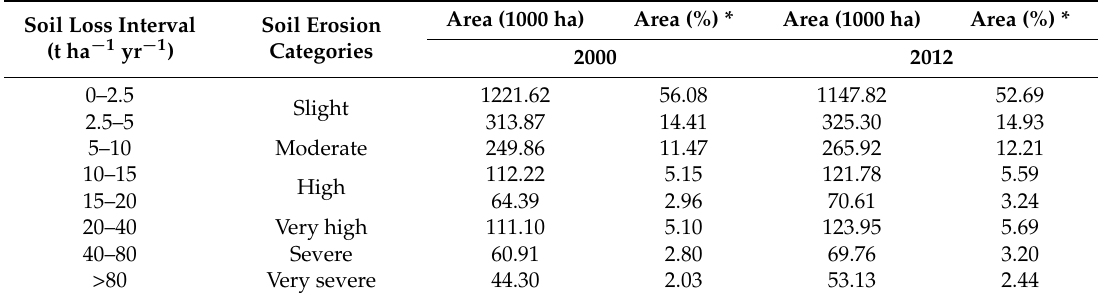
Table 5. Intervals of soil losses simulated for the land use conditions (entire Cerrado) in 2000 and 2012 on the Brazilian